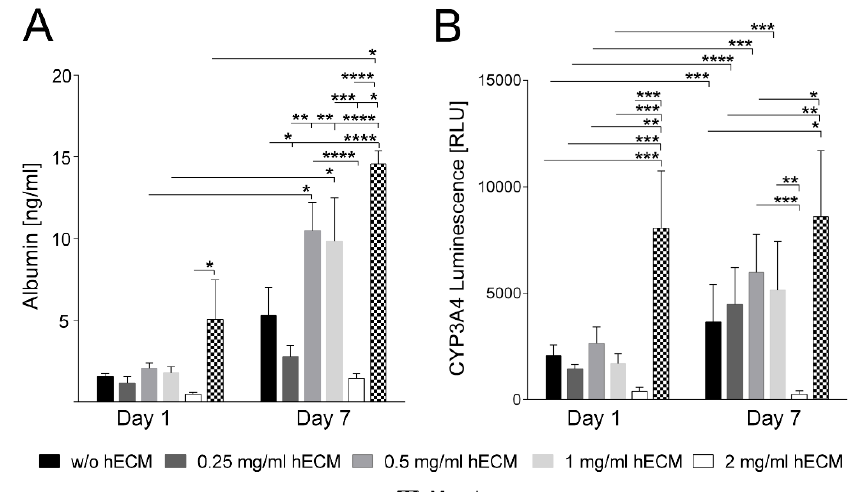
Figure 3. Albumin secretion and cytochrome P450 3A4 activity of printed mature HepaRG cells. ( A ) Quantitative enzyme-linked immunosorbent assay (ELISA) analysis of albumin secretion of mature HepaRG cell-laden 3D alginate/gelatin constructs with different ECM concentrations on day one and day seven; ( B ) CYP3A4 activity analysis of printed mature HepaRG cells determined by CYP3A4 induced luminescence. Comparison between the different ECM concentrations on day one and day seven. CYP3A4 luminescence was normalized to 10% Triton-X-100 treated cell lysis controls. Data from monolayer cultures are shown for comparison. Results are shown as mean ± SEM of three independent experiments. * p ≤ 0.05; ** p ≤ 0.01; *** p ≤ 0.001; **** p ≤ 0.0001.